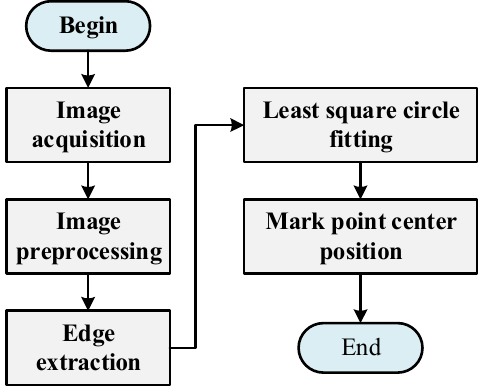
Figure 13. Visual processing flow.